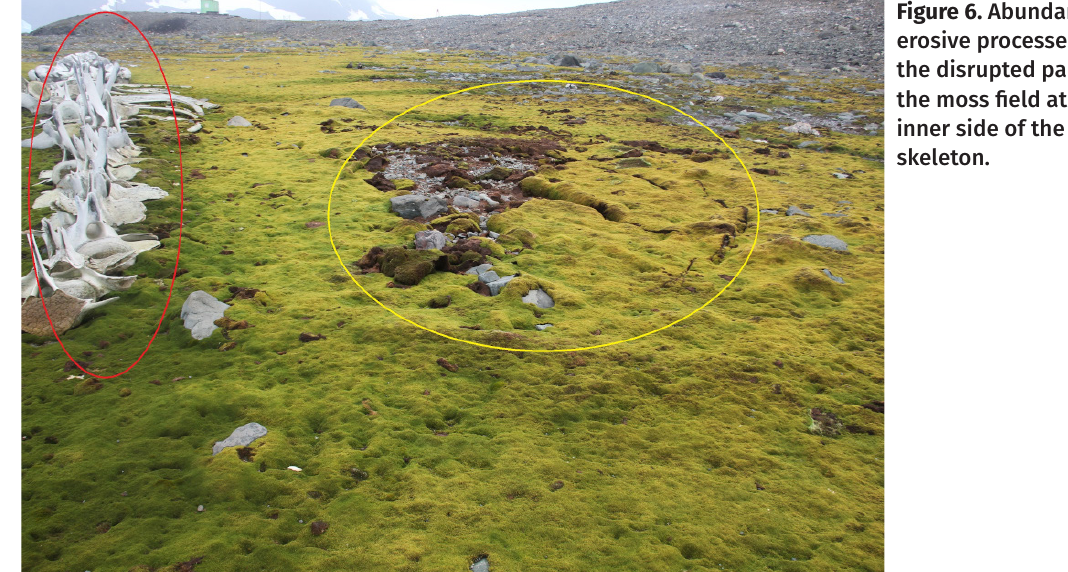
Figure 6. Abundant erosive processes in the disrupted part of the moss field at the inner side of the whale